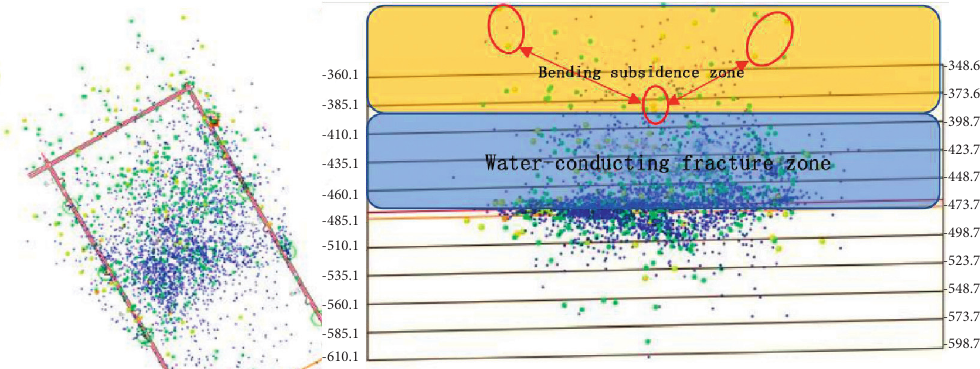
Figure 8: Plan and profile of the 16001 working face microseismic event distribution in the square